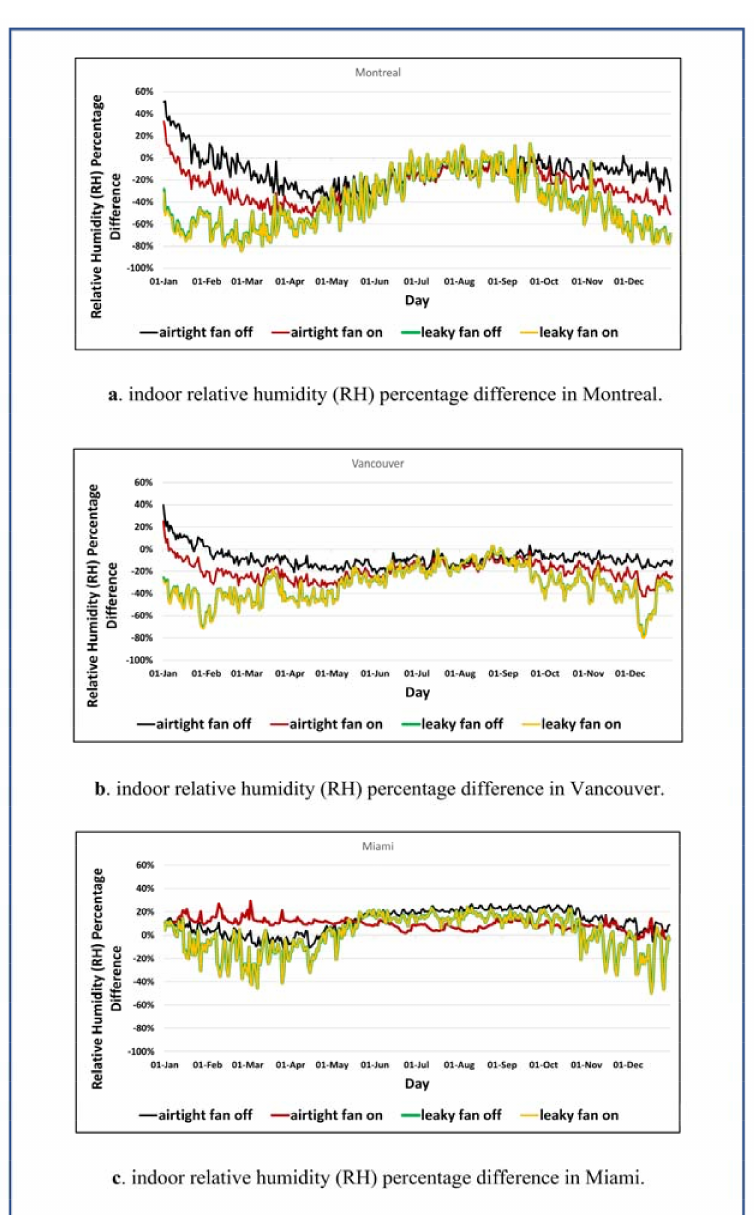
Figure 6. Comparison of the simulated WUFI results of hourly relative humidity (RH) with acceptable level of ASHRAE Standard 160 for ( a ) Montreal, ( b ) Vancouver, and ( c ) Miami